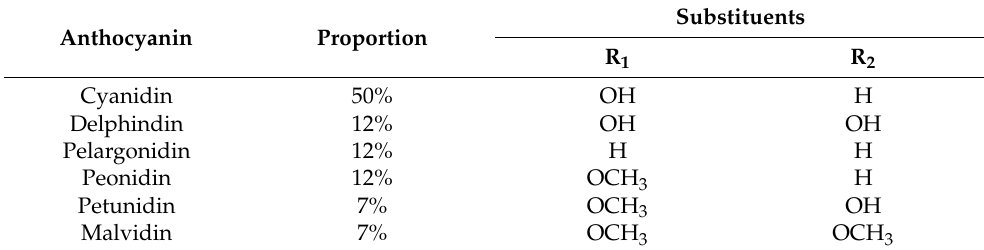
Figure 1. Chemical structure of anthocyanins.